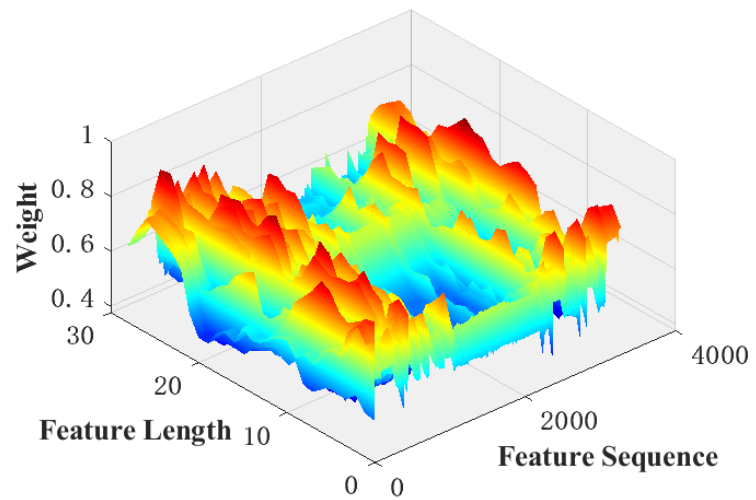
Figure 10. Weight of different spatial position in global weight average pooling.